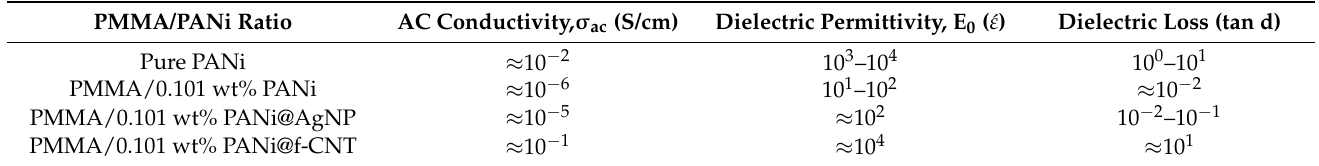
Table 10. AC conductivity ( σ ac ), Dielectric Permittivity (E 0 ), and Dielectric Loss (tan d) of PMMA with various amount of PANi hybrid nano-composites